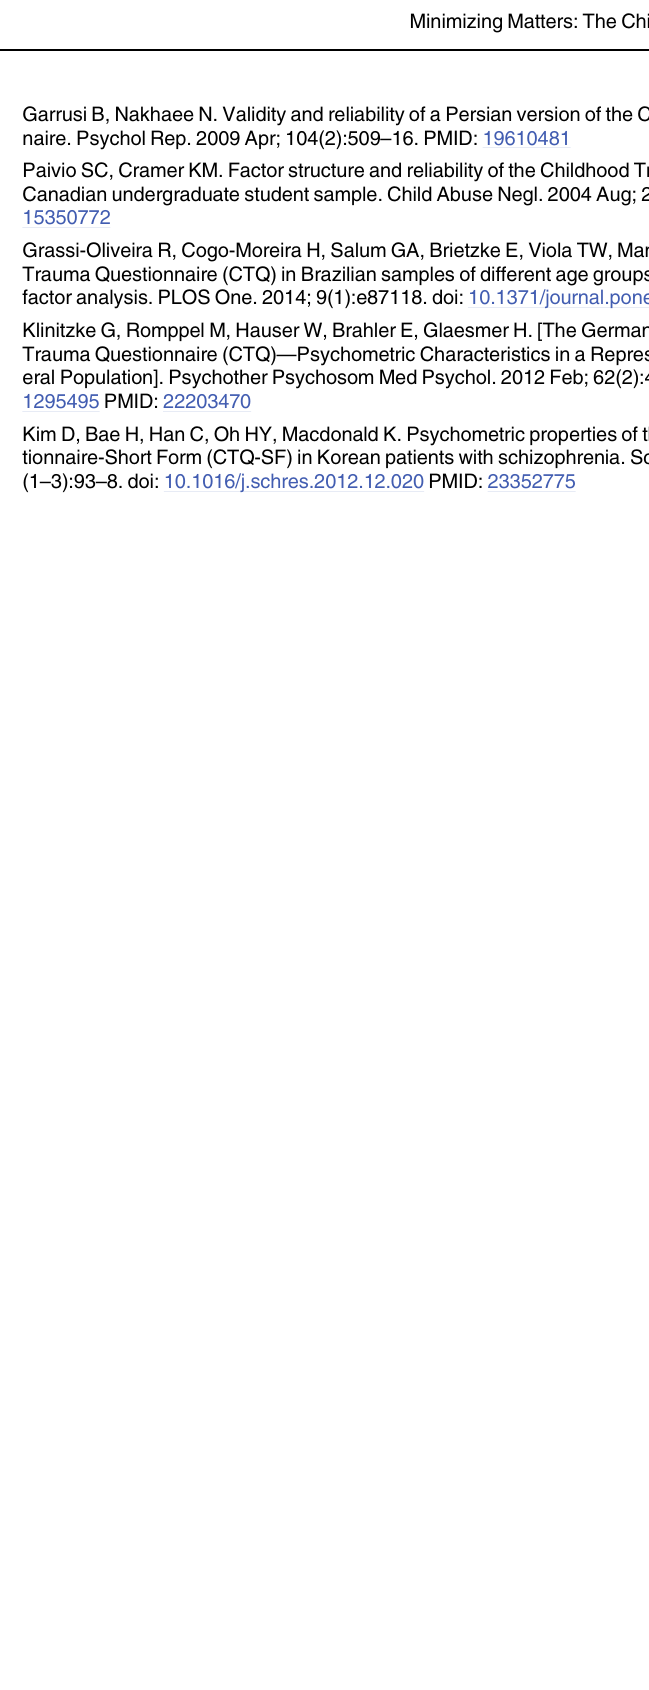
PLOS ONE | DOI:10.1371/journal.pone.0146058 January 27,